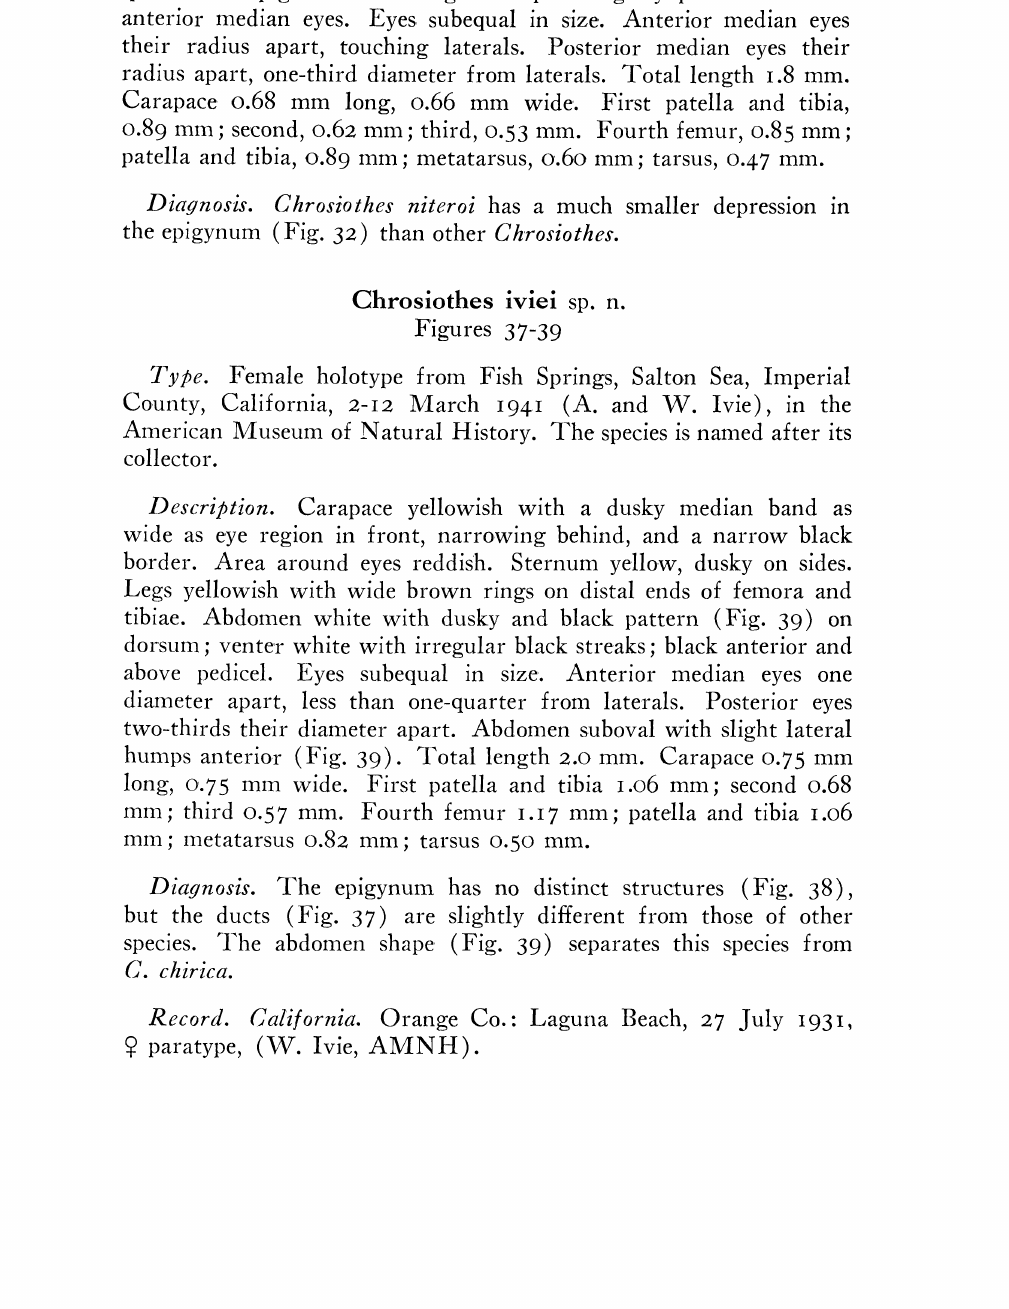
Description. Carapace, sternum olive-gray. Legs yellow with nar- row gray rings. Abdomen spotted with white, gray and black pigment on dorsum (Fig. 33); black on renter with many fine light yellow spots, where pigment is lacking. Carapace slightly pointed between their radius apart, touching laterals.. Posterior median eyes their radius apart, one-third diameter from laterals. Total length .8 mm. Carapace. 0.68 mm long, 0.66 mm wide’. First patella, and